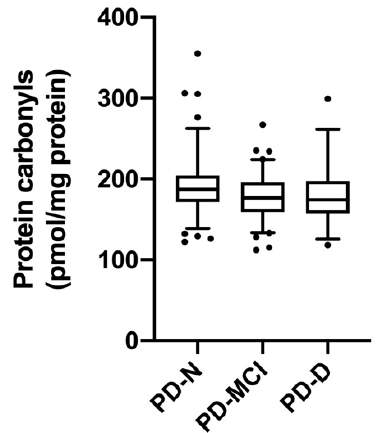
Figure 4. Plasma protein carbonyl concentrations relative to cognitive function. Plasma protein carbonyl concentrations in individuals with Parkinson’s disease as per cognitive status subgroups: normal (PD-N, n = 94), mild cognitive impairment (PD-MCI, n = 84), and dementia (PD-D, n = 34). The cognitively impaired group (PD-MCI and PD-D combined, n = 118) was significantly lower than the PD-N group ( p = 0.007). Box plots show medians with boundaries set at 25th and 75th percentiles, whiskers at 5th and 95th percentiles, outliers are indicated by symbols (two outliers in the PD-N subgroup are not shown on the figure; 969 and 603 pmol/mg protein).